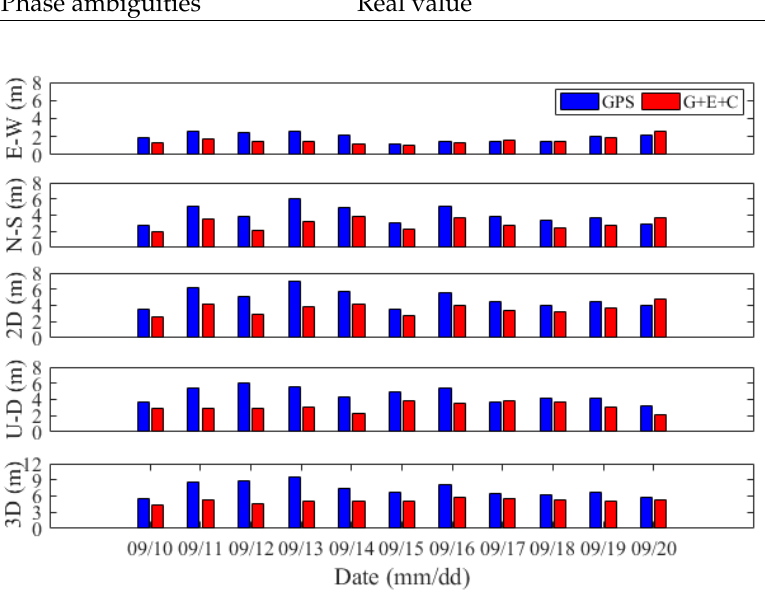
Figure 10. RMS values of SF RT–PPP in east, north, horizontal (2D), up, and 3D directions for GPS and multi–GNSS from 10 to 20 September